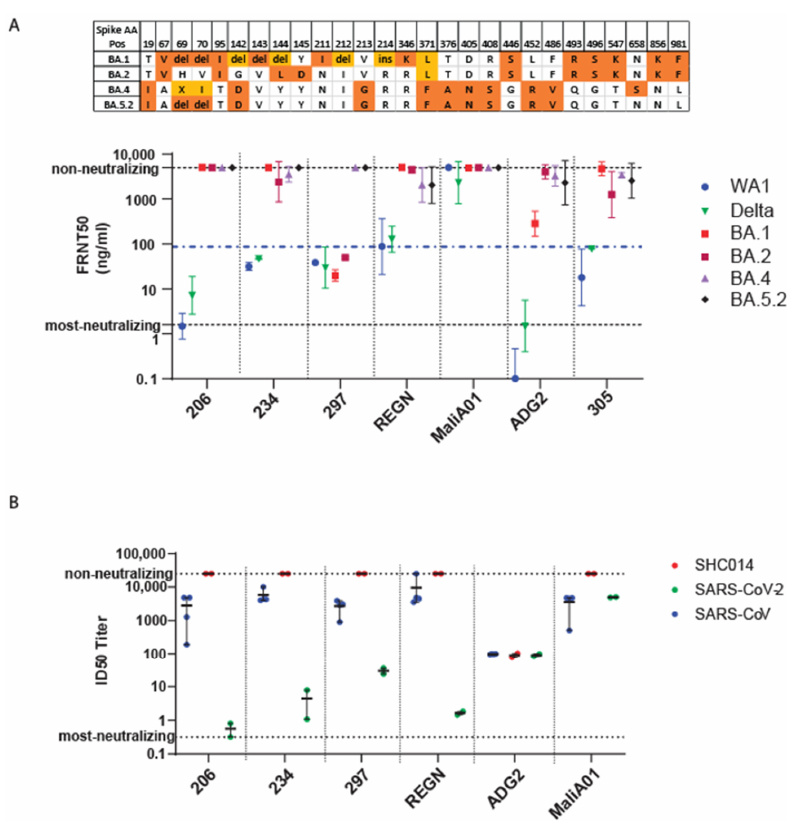
Figure 5. Mab neutralization. ( A ). Upper : Spike protein aa changes comparing Omicron BA.1, BA.2, BA.4, and BA.5 variants. Aa position (AA Pos) in the spike protein is indicated by position number. Del: deletion; ins: insertion. Non-colored (white background) denotes ancestral aa conservation. Colors indicate site variation, with shading marking specific sites of shared changes in multiple variants or unique changes. Lower : Geometric mean and standard deviation FRNT50 in ng/mL Mab concentration shown for the indicated Mabs. 206, 234, 297, and 305 are Mabs that were identified in previous studies for the neutralization of ancestral SARS-CoV-2 [35]. REGN, Regeneron 10987/10933 mAB cocktail. MaliA01 is a negative control antibody against a Plasmodium falciparum protein and is used to establish the non-neutralizing threshold. ADG2 is a positive-control Mab for SARS-CoV. Lower and upper dotted lines mark the FRNT50 levels for most neutralizing and non-neutralizing concentrations, respectively, of the tested Mabs. The middle (blue) dotted line shows the FRNT50 of positive control Mab REGN against WA1. ( B ). ID50 titer analysis of virus neutralization. Mean